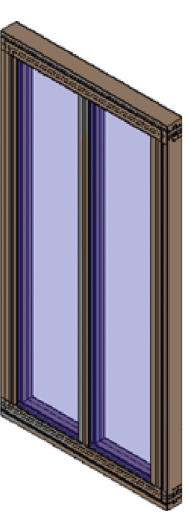
Figure 12: BIM model of test case